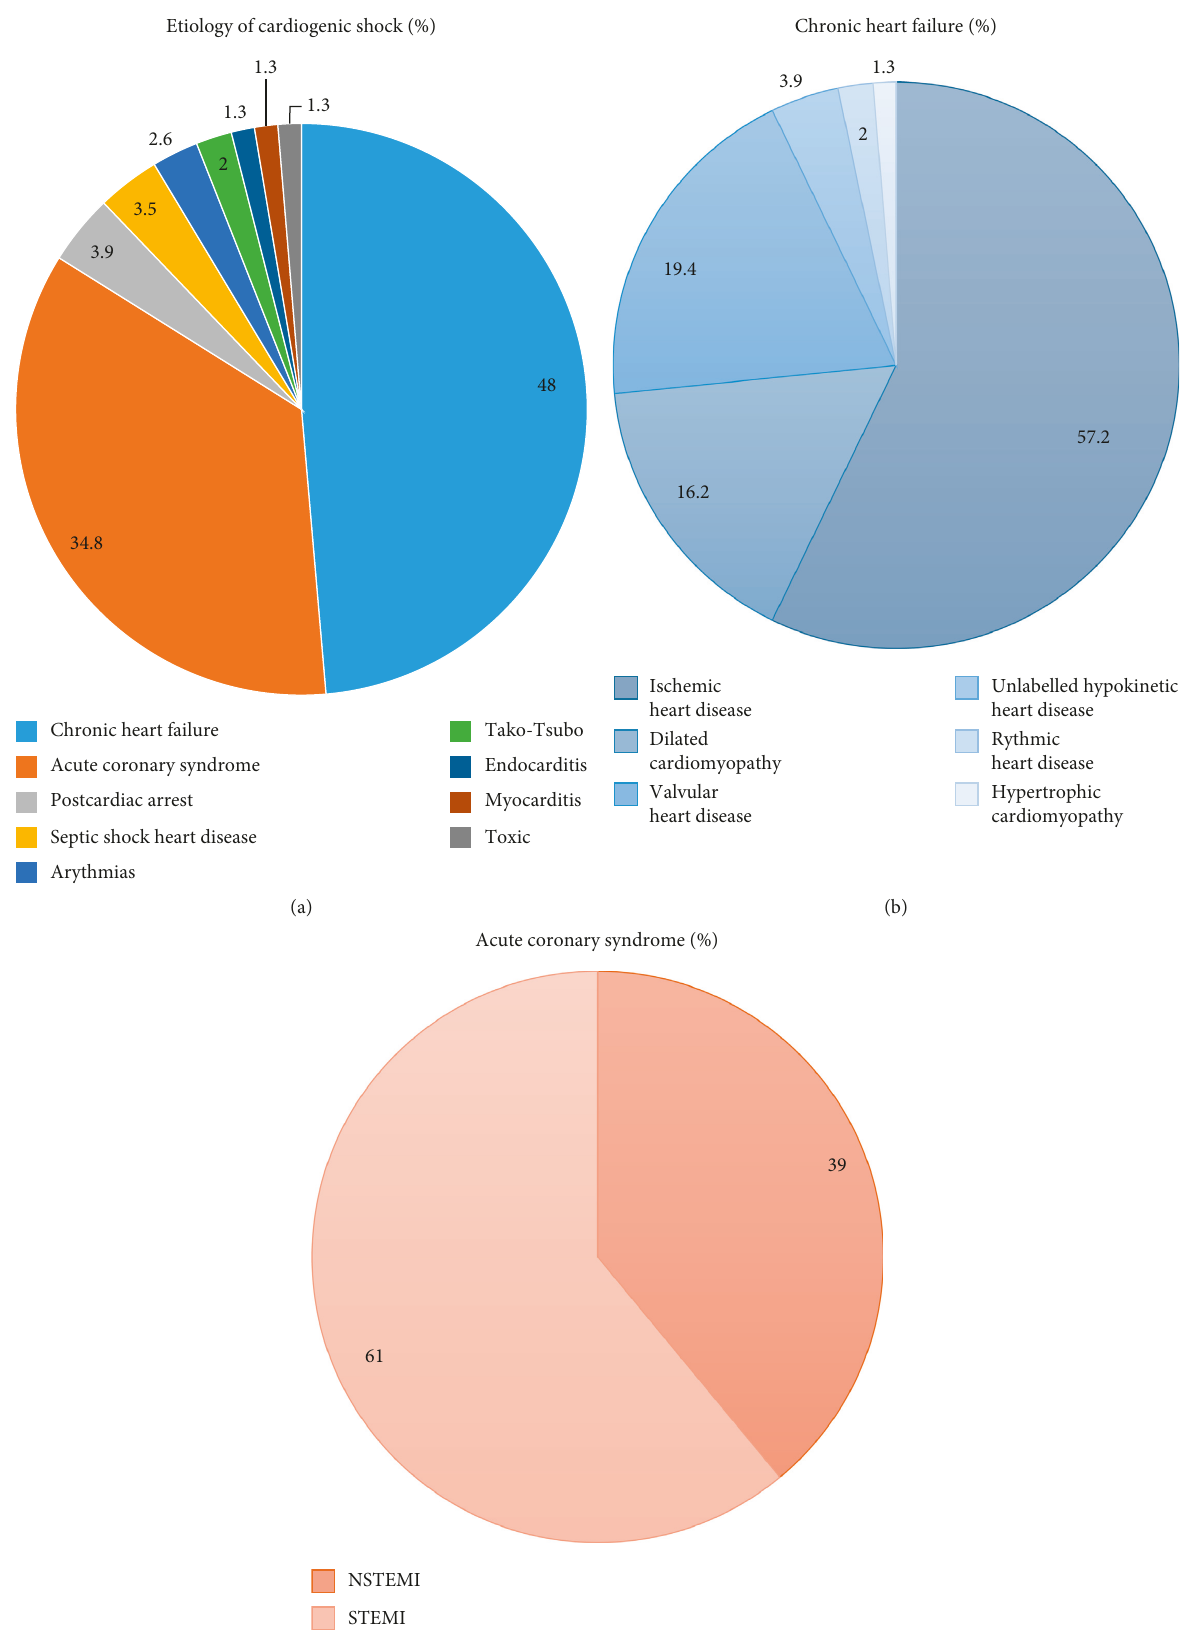
Figure 1: Panel (A), etiologies of CS; Panel (B), underlying cause of chronic heart failure; Panel (C), type of acute coronary